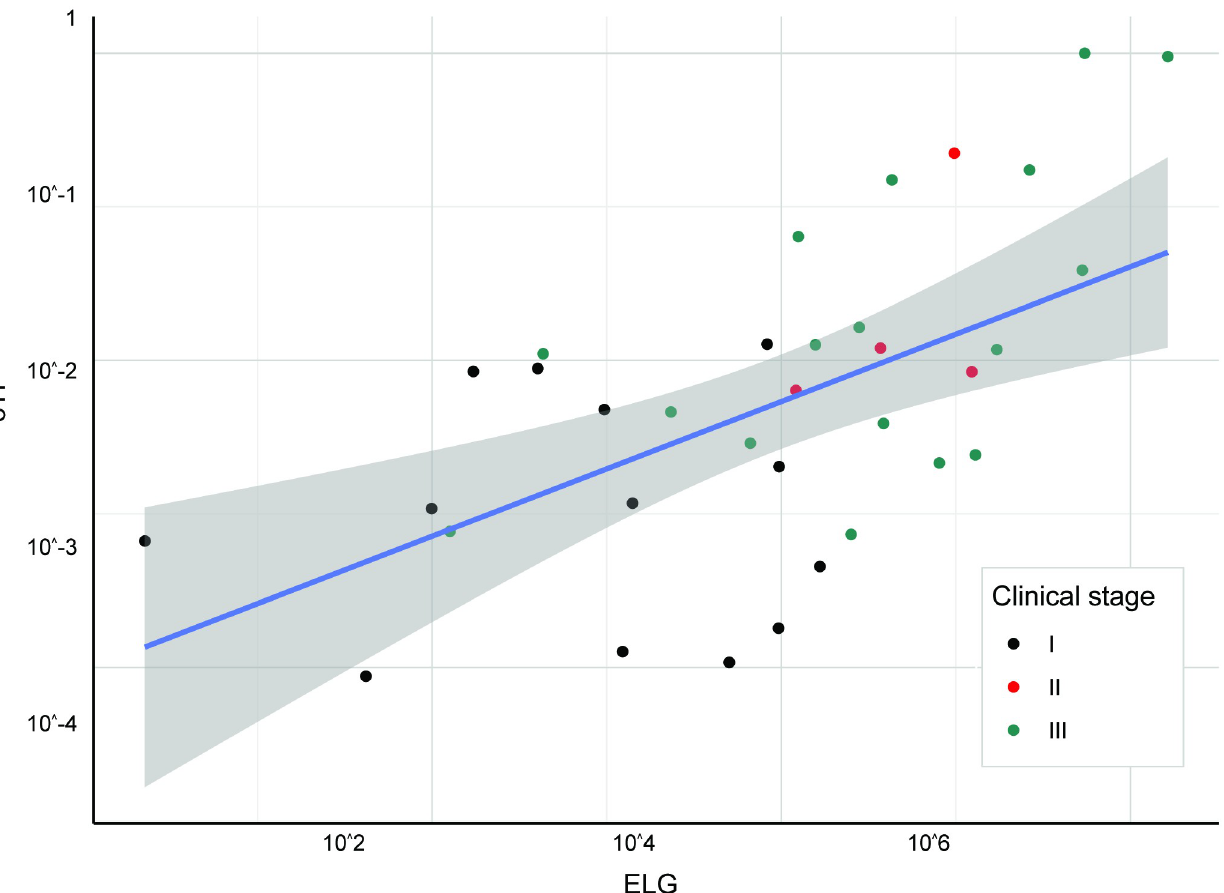
Table 3 shows the analytical model for colorectal cancer. Only TSA of deeply invading tumors was identified to contribute significantly to cTF, accounting for 75% of explained vari- ability. While not statistically significant, histologic grade and TSA of shallow invading tumors accounted for 12% and 11%, resp.